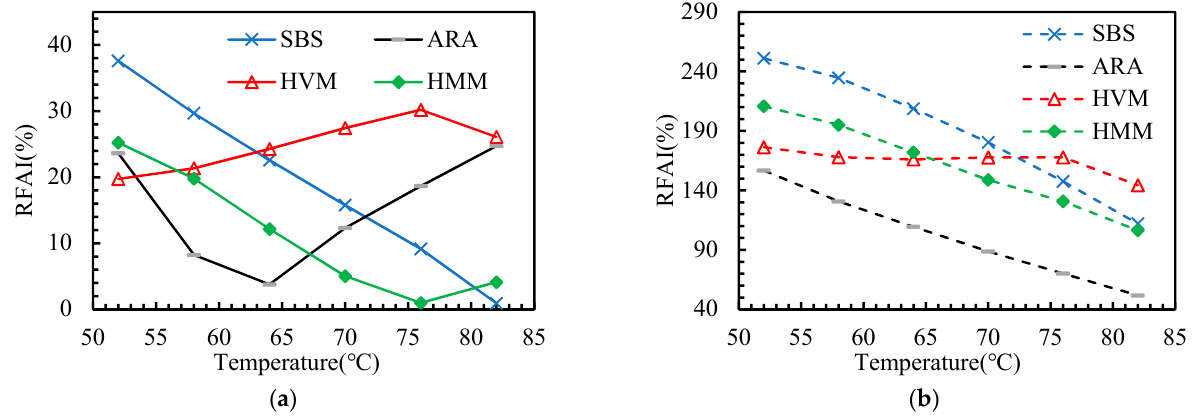
Figure 11. R utting Factor Aging Indicator (RFAI) of the asphalt binders after aging: ( a ) TFOT; ( b ) PAV.